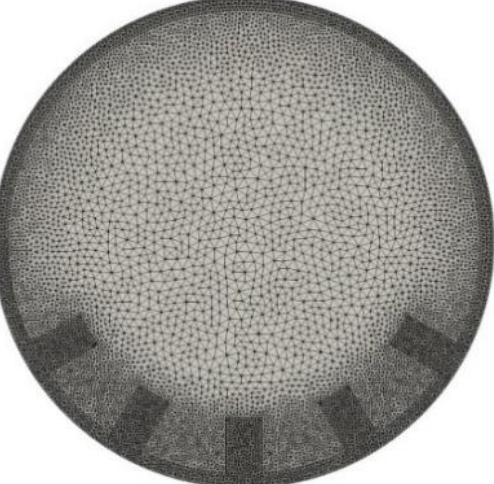
Figure 3. We first mesh the 2D cross section of the structure with unstructured triangular elements, and then convert it into 3D. The element density of near-wall regions in fluid domain is increased where there are high-velocity gradients.